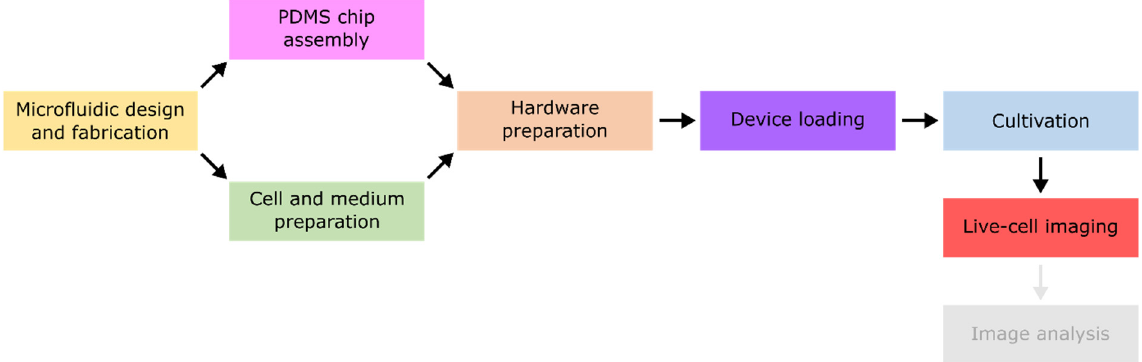
Figure 2. Flow diagram summarising the most important steps during a MC experiment. The experimental workflow is divided into seven consecutive steps: Microfluidic design and fabrication, PDMS chip assembly, cell and medium preparation, hardware preparation, device loading, cultivation, and live ‐ cell imaging. Since the subsequently required image analysis is not a part of this work, it is blurred.